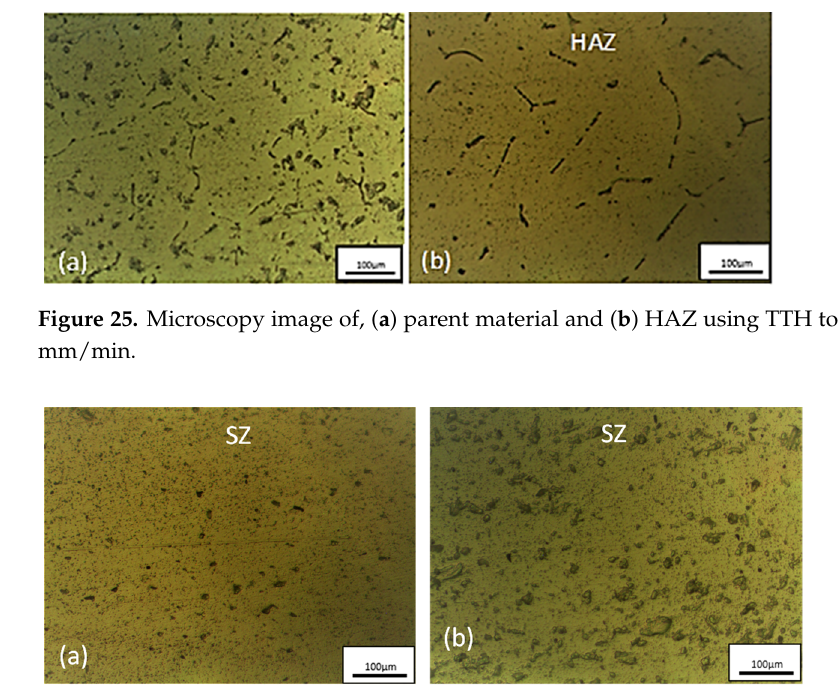
Figure 26. Microscopy image of, ( a ) SZ at 1150 rpm, 30 mm/min and ( b ) SZ at 1200 rpm, 20 mm/min.